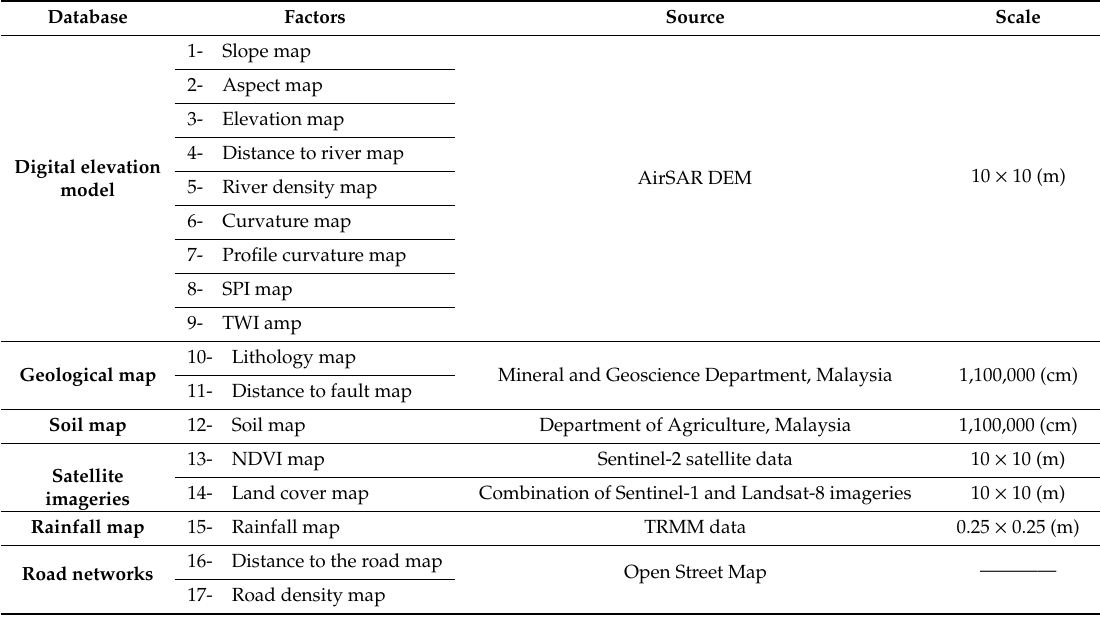
Table 1. Database of the current